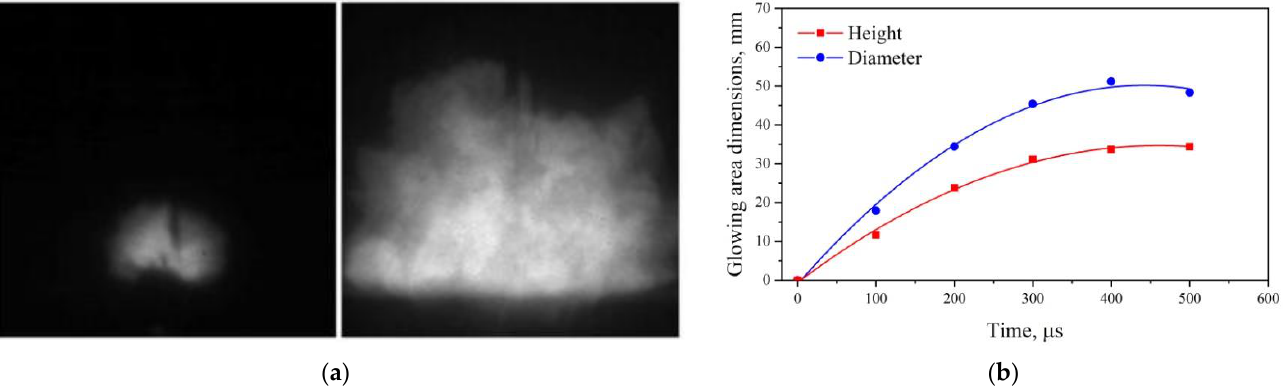
Figure 4. Combustion of Al – CuO mixture on a surface. ( a ) Typical photographs, 300 μs and 900 µs after ignition. ( b ) Expansion dynamics of glowing area.